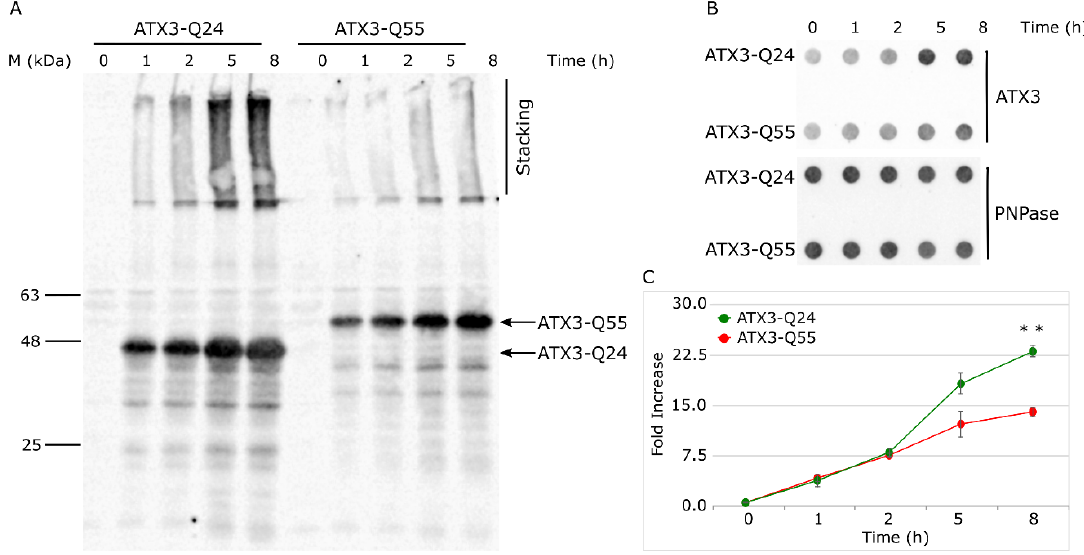
Figure 2. Analysis of ATX3 protein expression at different growth times. ( A ) SDS-PAGE (12%) and western blot analysis of protein total extracts (TE) obtained from E. coli Rosetta strains expressing ATX3-Q24 and ATX3-Q55. Cells were collected at different times after induction (t = 0, 1, 2, 5, and 8 h) and processed as detailed in Materials and Methods. Moreover, 20 µL of TE samples were boiled for 10 min and separated in SDS-PAGE, blotted onto Odyssey nitrocellulose membrane (LI-COR). ATX3 Z46 rabbit polyclonal antibodies [36] and IRDye fluorescent rabbit secondary antibody (LI-COR) was used for the immunodetection. Black bars indicate the migration of protein markers. Arrows represent the migrations of ATX3-Q24 and ATX3-Q55. The related gel stained with EZ-Blue Gel staining solution (Sigma) is reported in Figure S1. ( B ) Dot blot and ( C ) densitometric analysis of TE.5 µL of TE samples were diluted in 150 µL final volume of Sample Buffer. Then, were boiled 10 min and vacuum filtered in 48-well dot-blot apparatus through Odyssey nitrocellulose membrane (LI-COR). ATX3 variants and PNPase protein were revealed using anti-ATX3 Z46 and anti-PNPase rabbit polyclonal antibodies respectively [37]. Dots were quantified by densitometry and normalized using PNPase as a loading control and t0 signal of each strain as blank. Lines represent ATX3-Q24 (black dots) and ATX3-Q55 (light grey dots). Error bars represent standard error and derive from at least three independent experiments. ** p -value < 0.01.